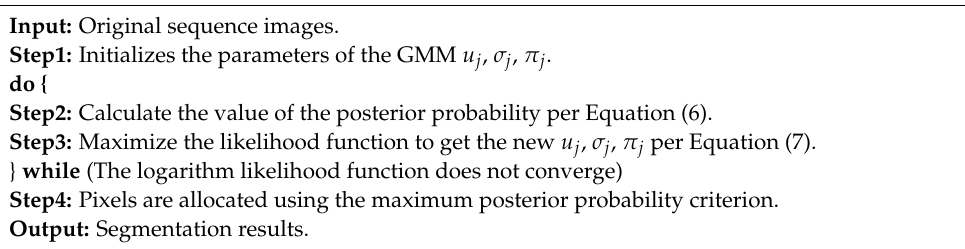
Algorithm 1 Gaussian mixture model combined with EM algorithm for image